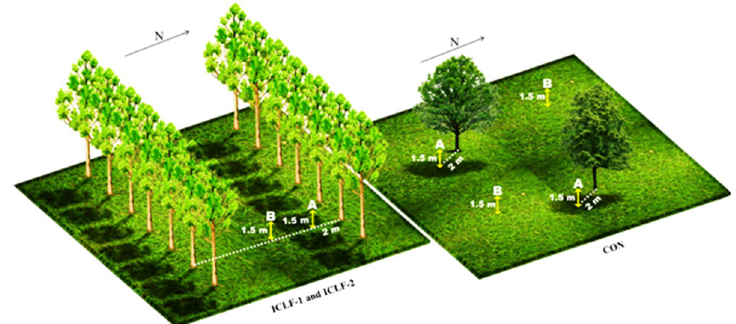
Fig 3. Schematic diagram of sampling points (A and B) in the integrated crop-livestock-forest (ICLF) systems (ICLF- 1, with 357 trees per ha and ICLF-2, with 227 trees per ha), and the control (CON) system (with five remaining native trees per